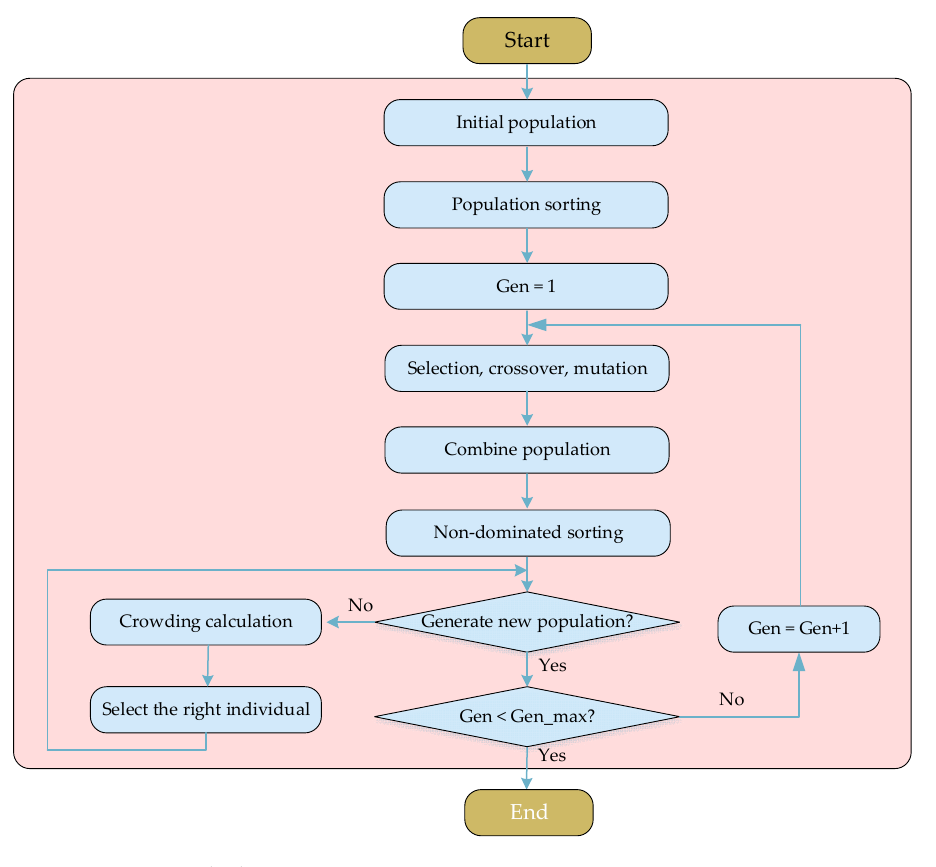
Figure 4. NSGA-II calculation process.